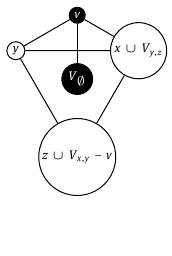
Figure 4: Structure of case (3).